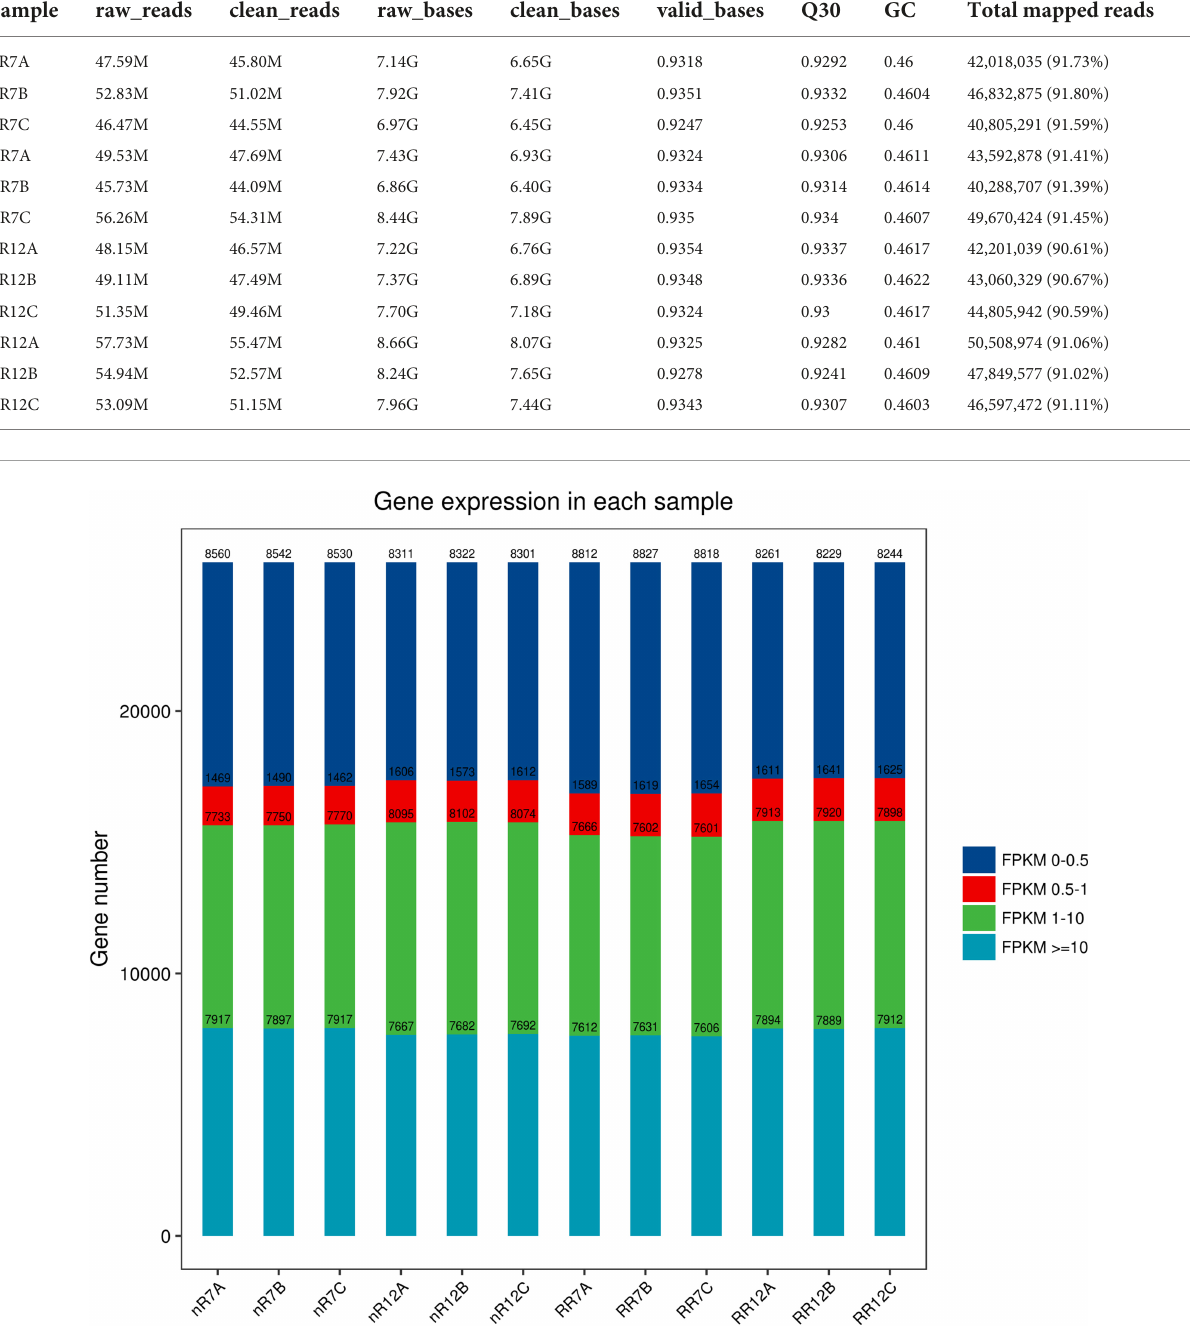
as shown in Figure 3B , 1532 and 2799 DEGs were obtained in the nR7 vs. RR7 and nR12 vs. RR12 comparison groups. There were 503 common DEGs in the nR7 vs. nR12 and RR7 vs. RR12 comparison groups